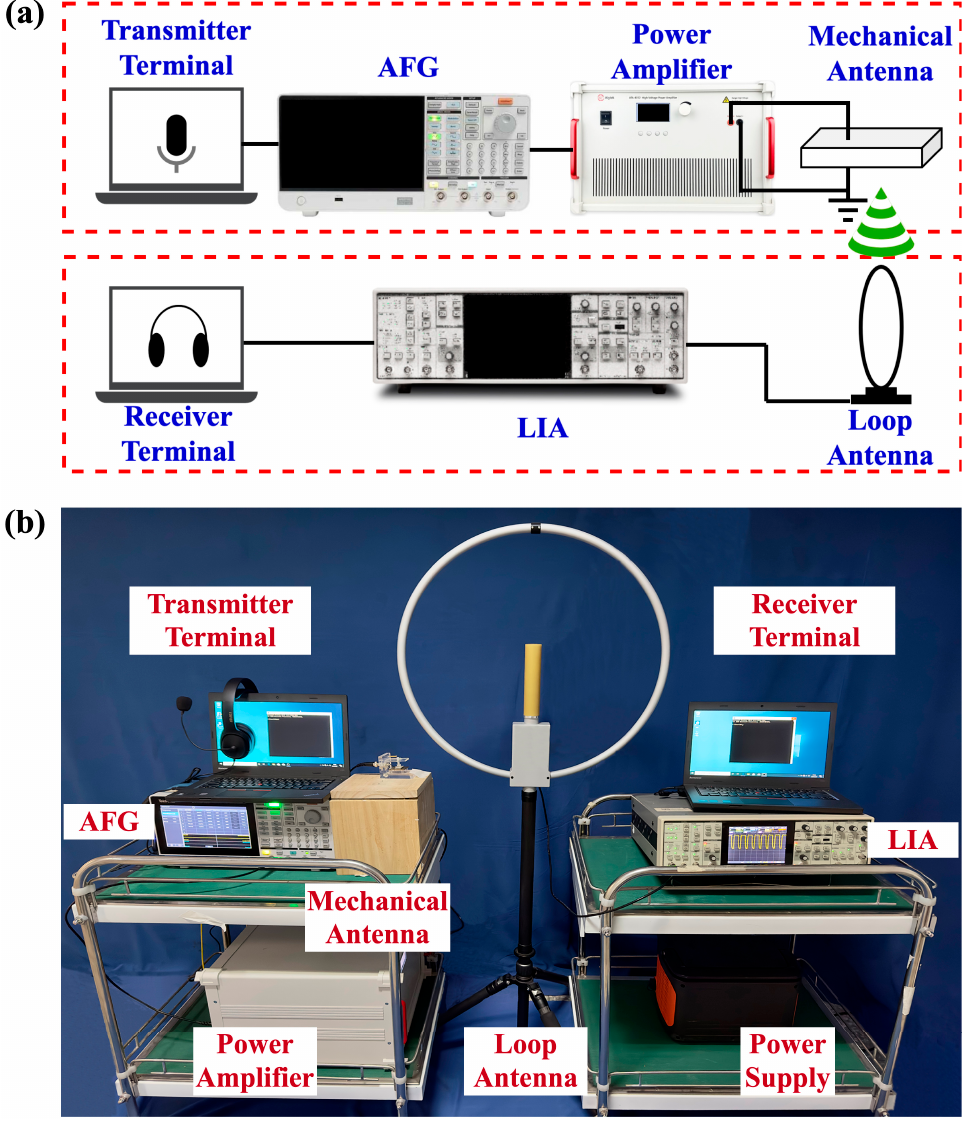
Figure 2. Hardware system of the speech communication system. ( a ) Architecture design. ( b ) A real-time photo of the measurement environment.